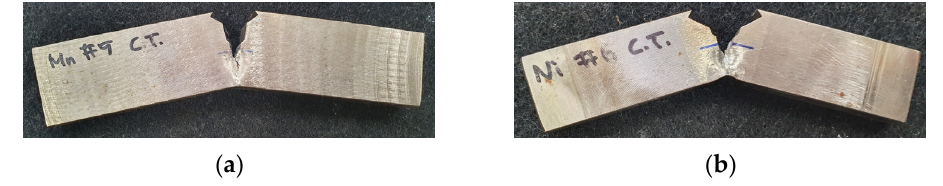
Figure 9. CTOD test specimens for the weld metals: ( a ) high Mn; ( b ) 9% Ni.